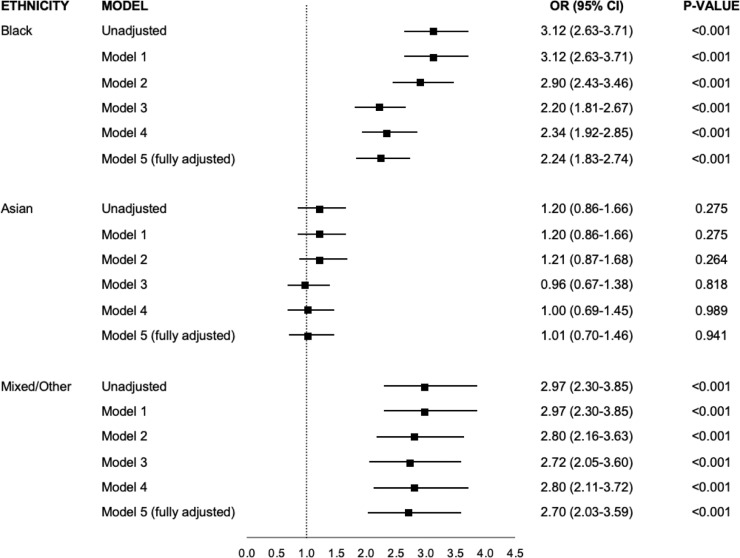
Association between ethnicity and risk of hospital admission for COVID-19.Odds ratios are compared to White ethnicityModel 1 – adjusted for age and sexModel 2 – adjusted for age, sex and index of multiple deprivationModel 3 – adjusted for age, sex and cardiometabolic comorbidities*Model 4 – adjusted for age, sex, and all comorbidities**Model 5 (fully adjusted model) – adjusted for age, sex, index of multiple deprivation, and all comorbidities*Cardiometabolic comorbidities include hypertension, coronary heart disease, heart failure, previous stroke/TIA, diabetes, chronic kidney disease.**Cardiometabolic comorbidities, asthma, chronic obstructive pulmonary disease.